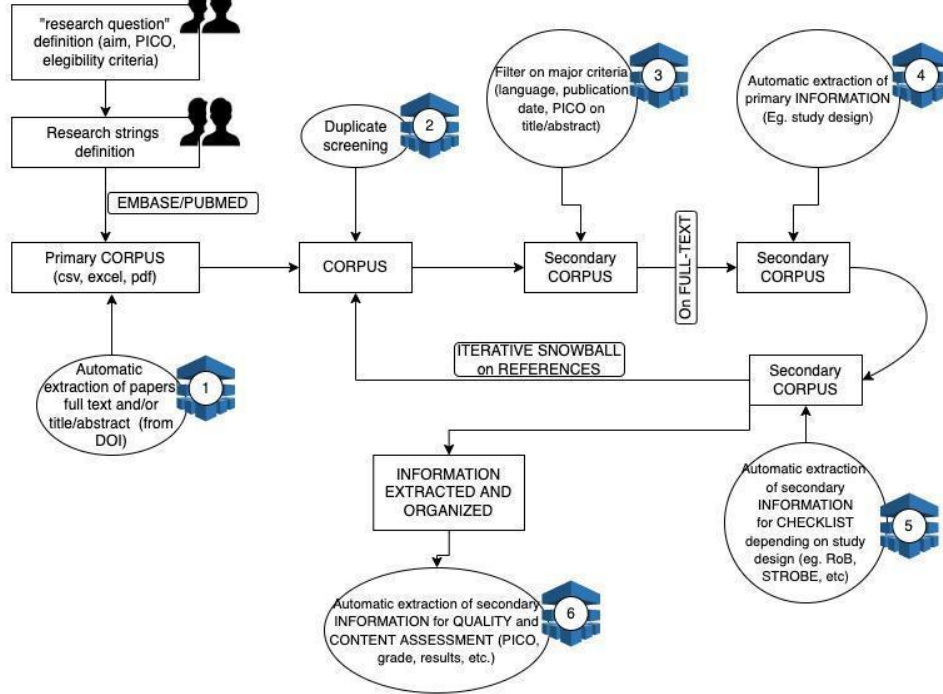
Figure 2. Systematic literature review workflow. The “blue icons” highlight the potentially automat- able nodes of the evidence extraction process.